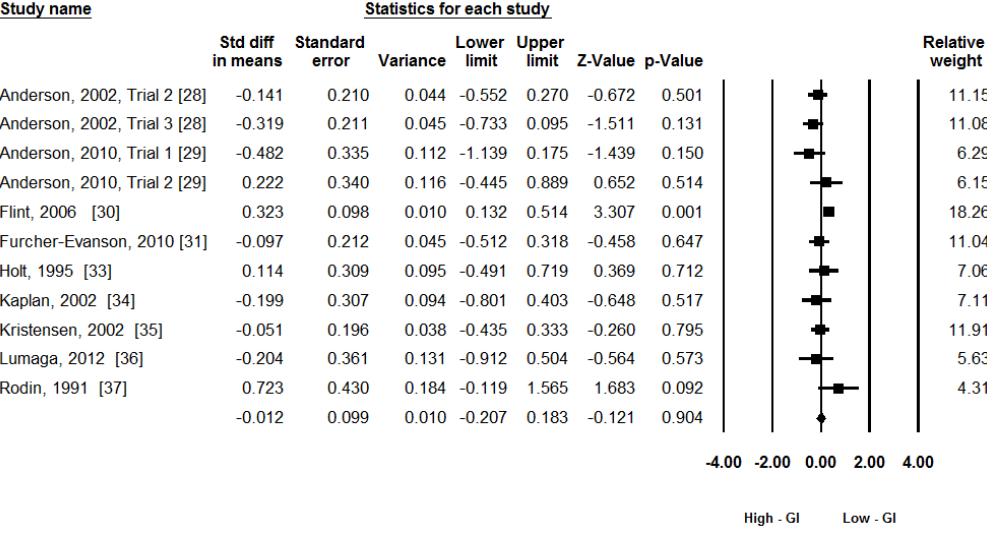
Figure 2. The effects of low ‐ GI and high ‐ GI breakfast on subsequent energy intake. (GI: Glycemic Index).